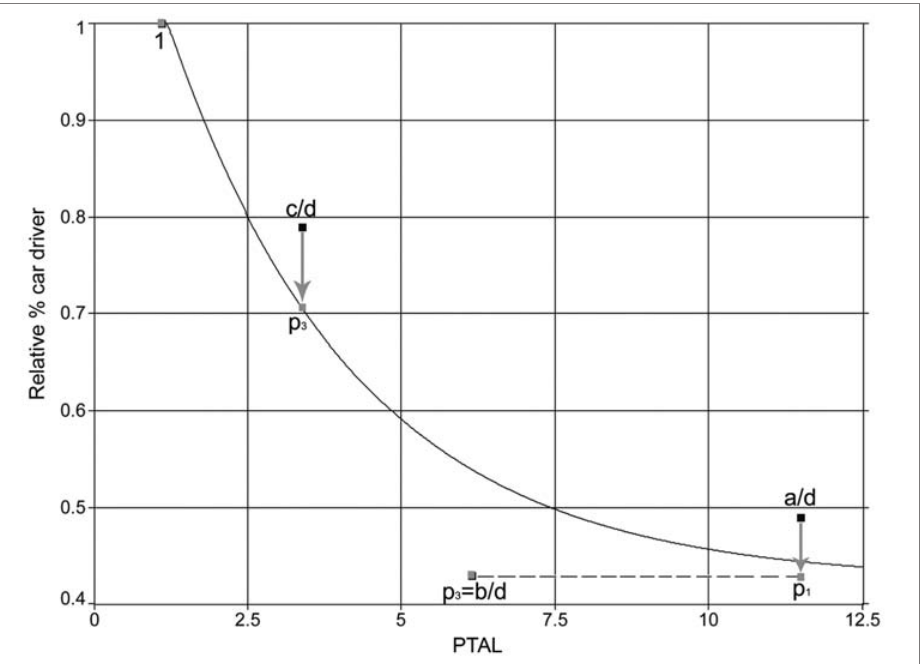
Fig. 3. Definition of adjusted relative % car